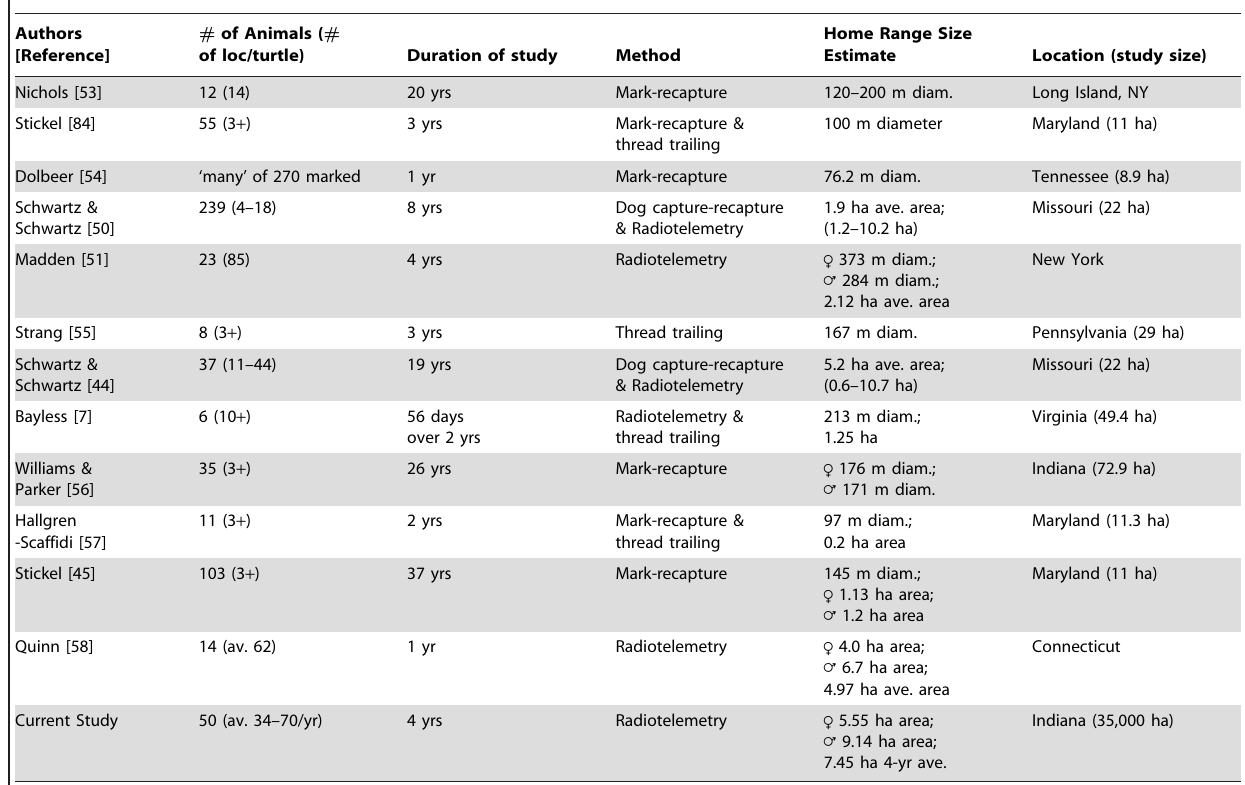
Table 3. Published studies involving home range estimates from native populations of T.